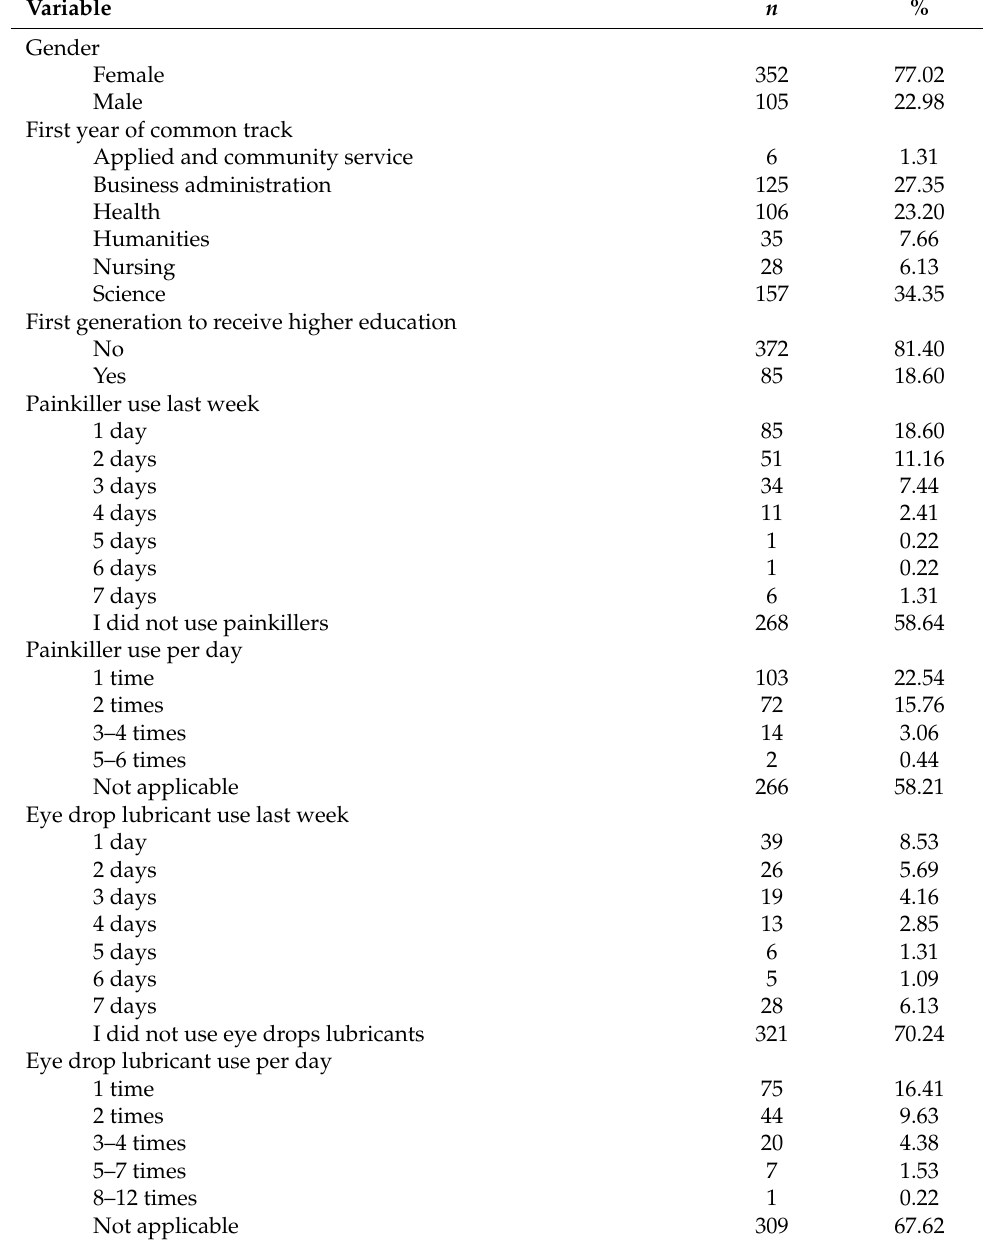
Table 1. Demographic characteristics of the sample ( n =